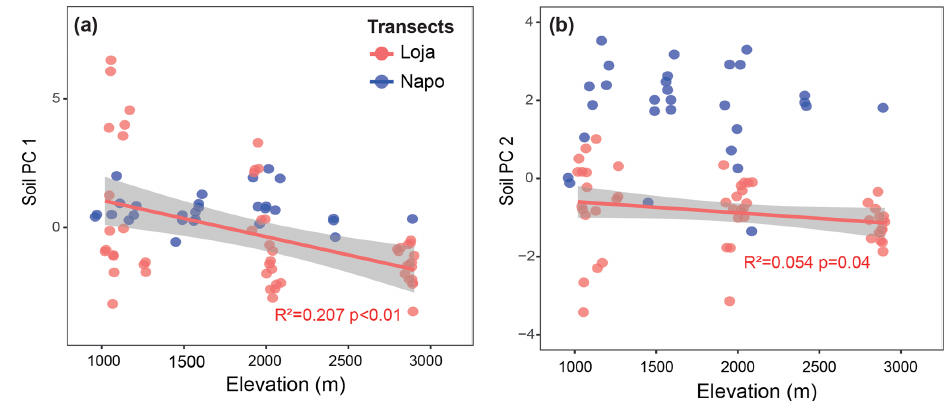
Figure 3. Variation in soil properties along the two forest transects (red dots: Loja transect; blue dots: Napo transect). Shown are the (a) first and (b) second principal components of the soil PCA (see Fig. B1 and Table B1).